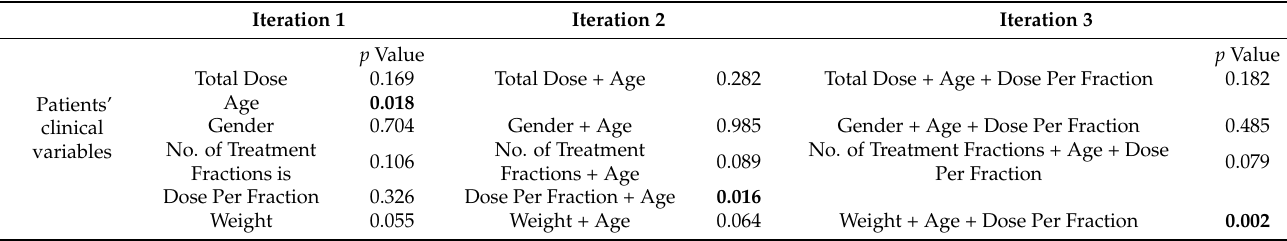
Table 4. Estimated coefficients used in AI coding.